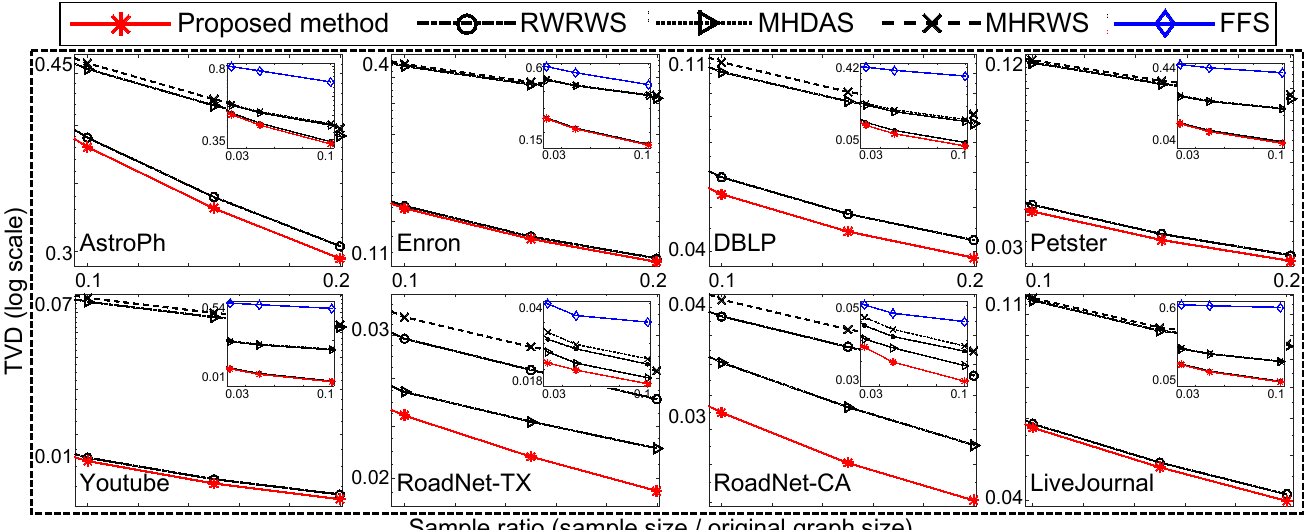
Figure 8. Comparison of sampling methods on clustering coefficients of networks.